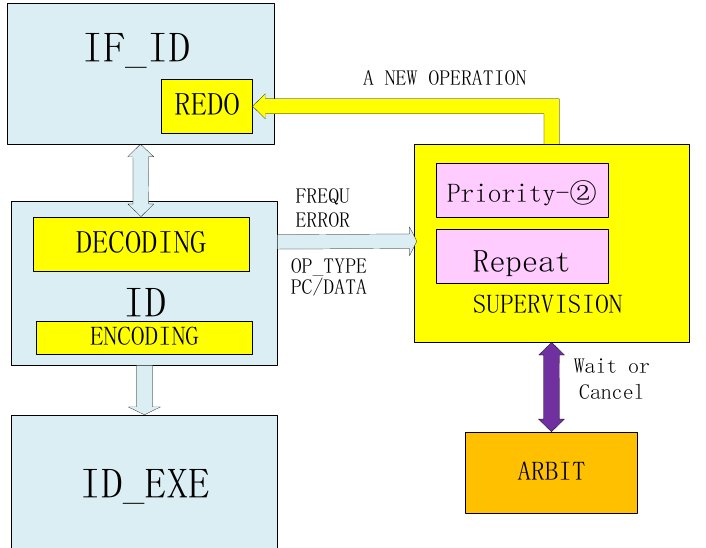
Figure 10. Fetching-decoding rollback process. After the data from the fetching module enters the timing logic, the data without error is sent to the decoding module. If there is an exception, the REDO operation will be executed at this stage to return the original data. The REDO operation is arbitrated by the ARBIT module, and then the SUPERVISION module is notified to give feedback.